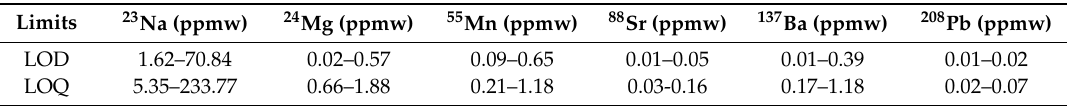
Table 2. Laser Ablation-Induced Coupled Plasma-Mass Spectrometer (LA-ICP-MS) detection limits and ranges in